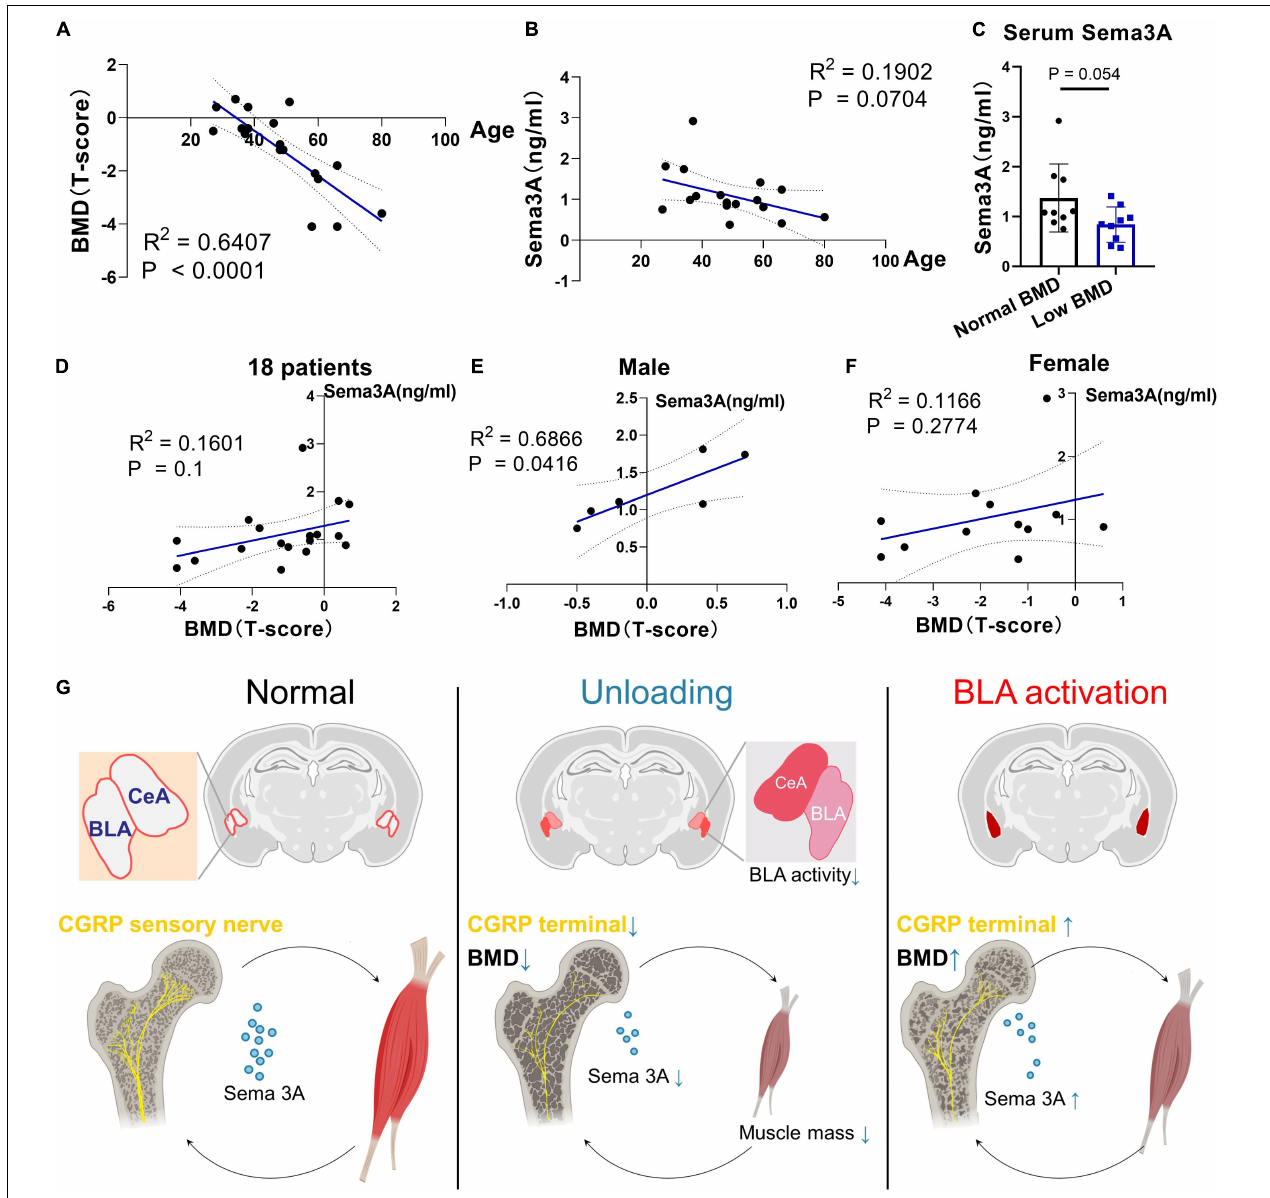
FIGURE 6 | Clinical cases for potential application of Sema3A as a prognostic signal of bone loss. (A) Correlation between BMD (T-score) and age (years) in 18 patients. (B) Correlation between BMD (T-score) and Sema3A level in 18 patients. (C) Serum Sema3A level between normal BMD group (T-score > –1) and low BMD group (T-score ≤ –1). (D) Correlation between BMD (T-score) and Sema3A level in 18 patients. (E) Correlation between BMD (T-score) and Sema3A level in male group. (F) Correlation between BMD (T-score) and Sema3A level in female group. For all clinical data, linear regression models were used to explore the correlation between two variables. P < 0.05 was considered significant. (G) Basolateral amygdala (BLA) mediates mechanosensory role of bone in response to mechanical